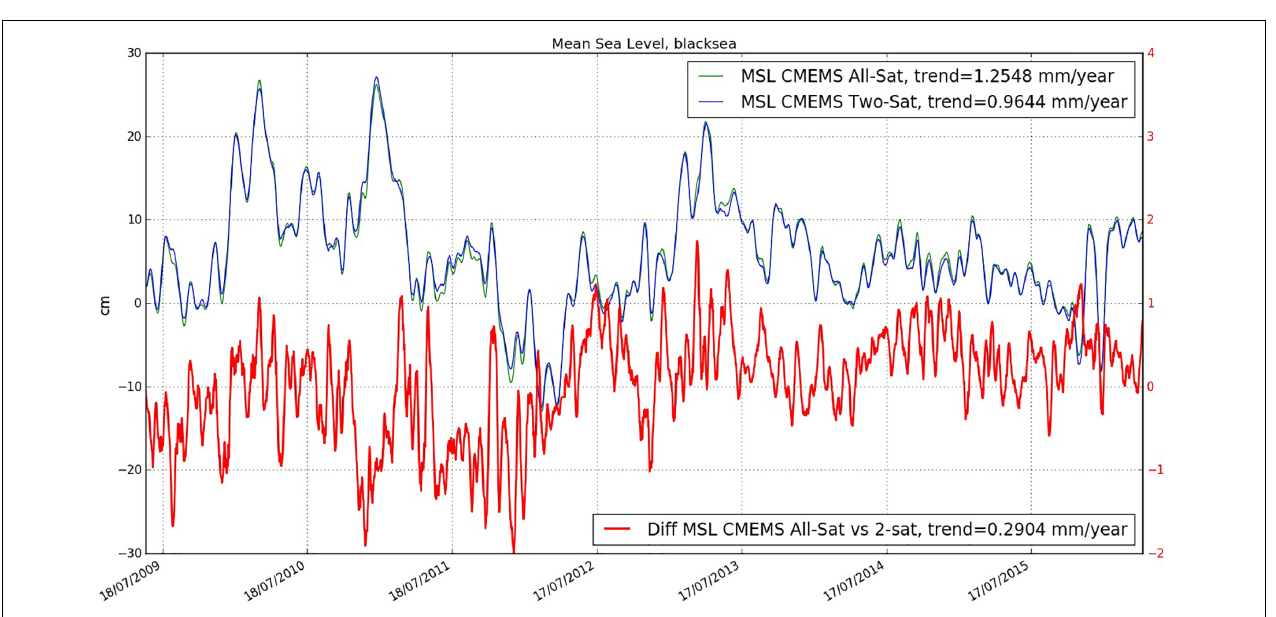
FIGURE 5 | Area-averaged mean sea level in the Black Sea: impact of the difference of constellation between the all-satellite merged dataset (CMEMS vDT2018, in blue) and the corresponding dataset in a two-satellite merged configuration (in green), in terms of mean sea level in the Black Sea and their difference (in red, in